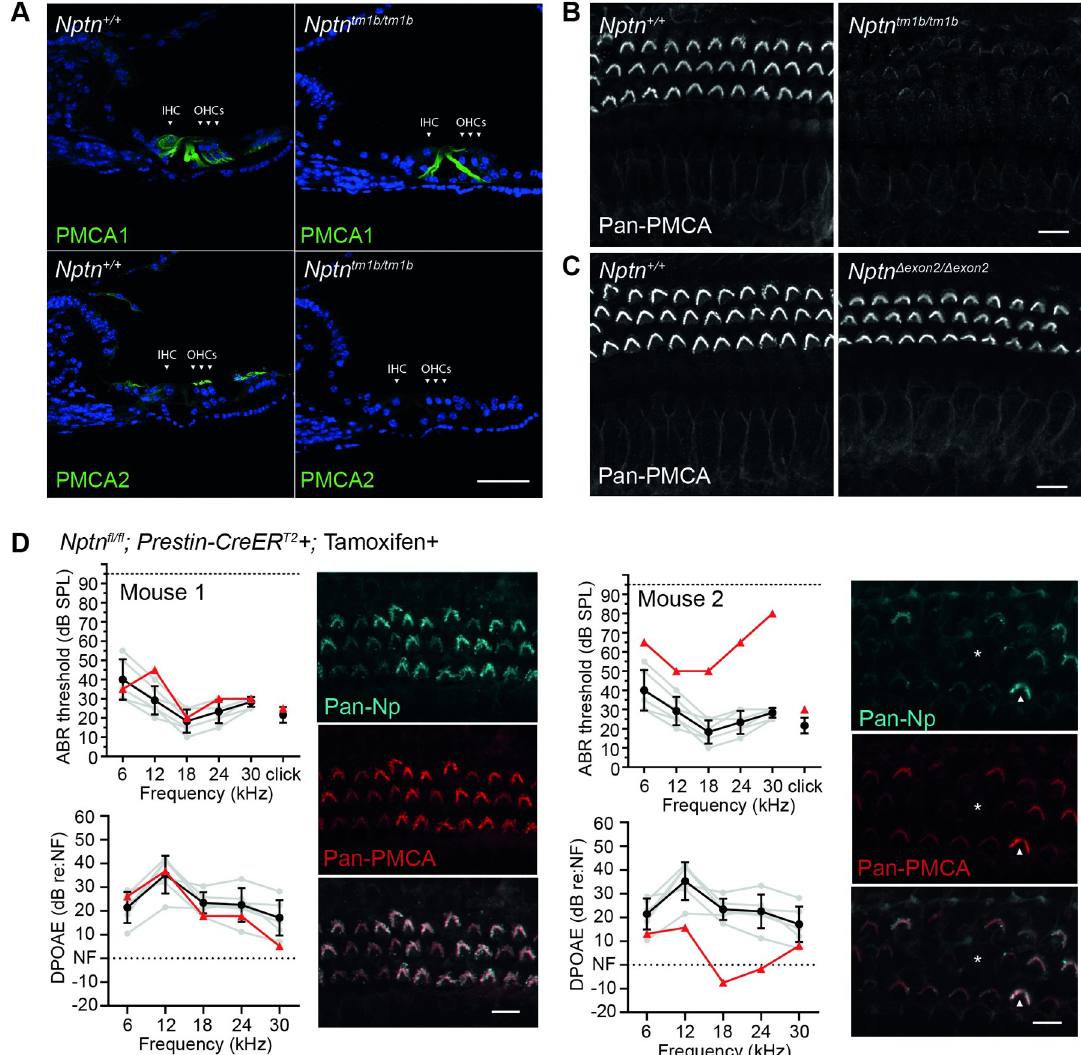
Fig 10. Hearing impairment is inversely correlated with Nptn-dependent localisation of PMCA in outer hair cell stereocilia. (A) Immunolabelling of cochlear cryosections using anti-PMCA1 and anti-PMCA2 antibodies. In wild type tissue, PMCA1 is predominantly localised to the membrane of IHCs and OHCs, whereas PMCA2 is localised to OHC stereocilia and lateral supporting cells. Labelling of the PMCAs at these locations was substantially reduced in Nptn tm1b/tm1b cochleae. Scale in (A) = 20 μ m. (B) The anti- pan-PMCA antibody detects PMCA1-4. Maximum intensity projections of whole-mount cochlear immunolabelling using the anti-pan- PMCA antibody showed labelling of OHC stereocilia and membrane of IHCs in Nptn +/+ mice, which were substantially reduced, but not absent, in Nptn tm1b/tm1b cochleae. (C) Using the anti-pan-PMCA antibody, no labelling differences were seen in Nptn Δ exon2/ Δ exon2 cochleae compared to wild-type. Images in (A), (B), and (C) taken from the mid-apical region of the cochlea. Scale in (B) and (C) = 10 μ m. (D) ABR threshold and DPOAE response measures from two Nptn fl/fl ;Prestin-CreER T2 + mice following tamoxifen-induced cre- mediated recombination, with corresponding anti-pan-Np and anti-pan-PMCA immunolabelled mid-apical cochlear whole mounts (maximum intensity projections). Data from the individual mice are shown (red triangles) compared against wild type controls (black circles, mean ± SD). Due to varying levels of induction, the auditory phenotype exhibited was variable with some mice showing no significant phenotype (e.g. Mouse 1), while others showed increased ABR thresholds and a decreased DPOAE response (e.g. Mouse 2). The auditory phenotype was directly correlated to the level of Nptn recombination as demonstrated by immunolabelling using the anti- pan-Np antibody. Bundles that were strongly stained for Neuroplastin also had strong labelling for anti-pan-PMCA antibody (arrowhead), whereas absent Neuroplastin was correlated with a weak PMCA signal ( � ).